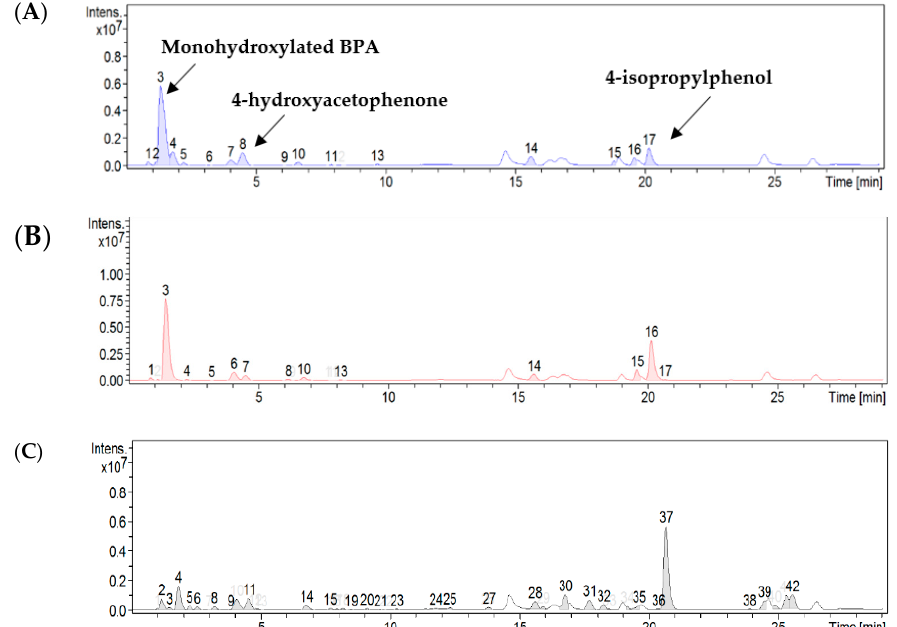
Figure 6. Chromatogram of bisphenol A degradation products using biosilica modified ruthenium ion: